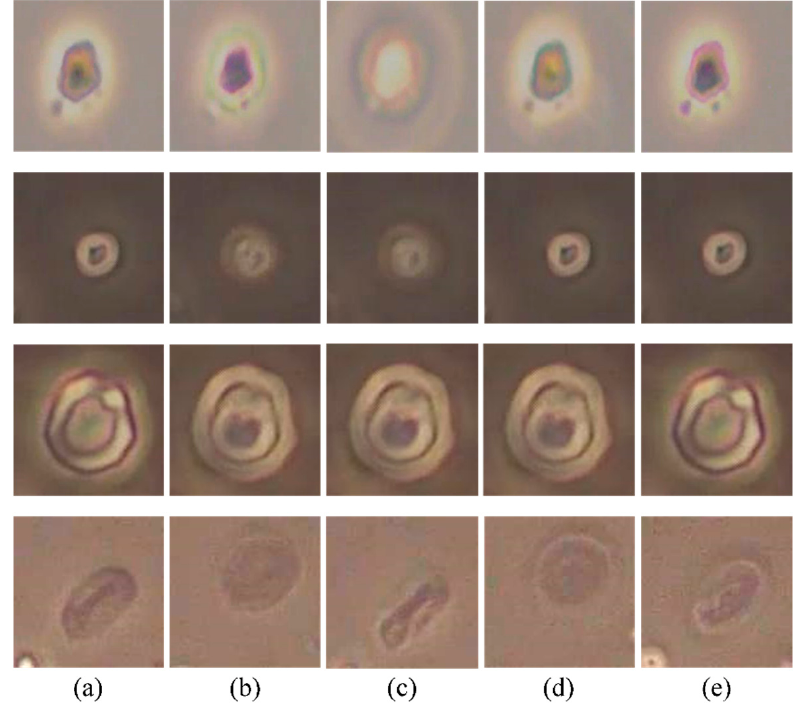
Figure 9. Key frames are extracted by different methods. ( a ) actual key frames; ( b ) key frames extracted by the K-FD model; ( c ) key frames extracted by the K-OF model; ( d ) key frames extracted by the MIL model; ( e ) key frames extracted by the EI-TC model adopted by this paper. Table 1. Comparison of PSNR, SSIM, and time consumption between four key frame extraction methods in different typical morphologies of urinary red blood cells. The bolded numbers are the best results.